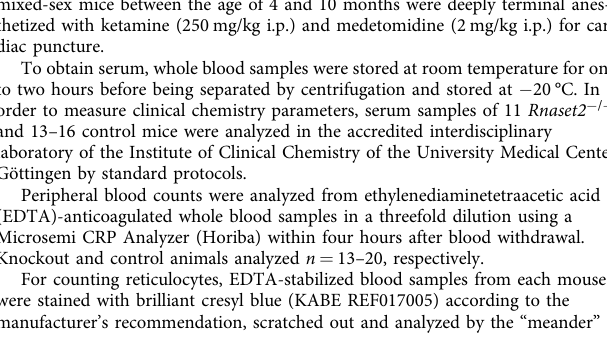
WT Rnaset2a allele and 870 bp for the transgene. For Rnaset2b -HDR allele genotyping was performed by genomic PCR with primers P4 (5 ‘ -CTGTCCTCTGT GGTGTGTATG-3 ‘ ) and P5 (5 ‘ -TGGAAGTATACCC-TCTCTCGGC-3 ‘ ) followed by Sanger sequencing with the same primers. Rnaset2 − / − Ifnar1 − / − double-knockout mice . For the Rnaset2 − / − Ifnar1 − / −